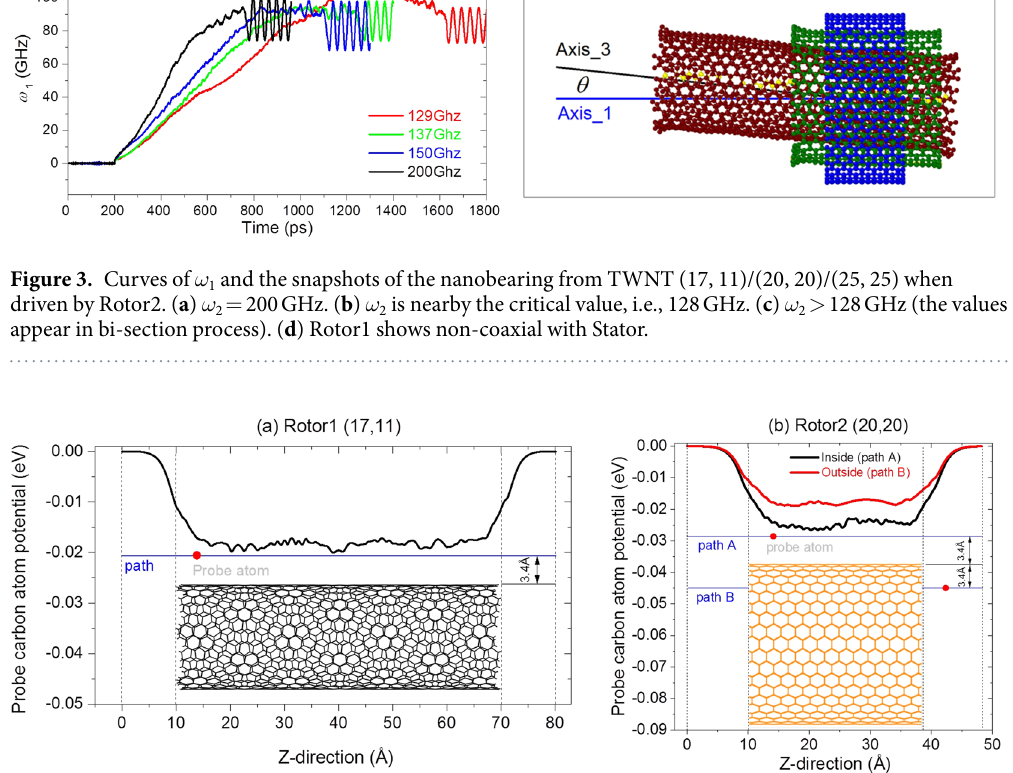
Figure 4. Potential of a probe of carbon atom (red point) when moving along the path (blue line) which is 3.4 Å away from a single tube. ( a ) Tube is Rotor1 (17,11), ( b ) tube is Rotor2 (20, 20). The tubes are chosen from the system after 200 ps of relaxation. Inserts are standard tubes before